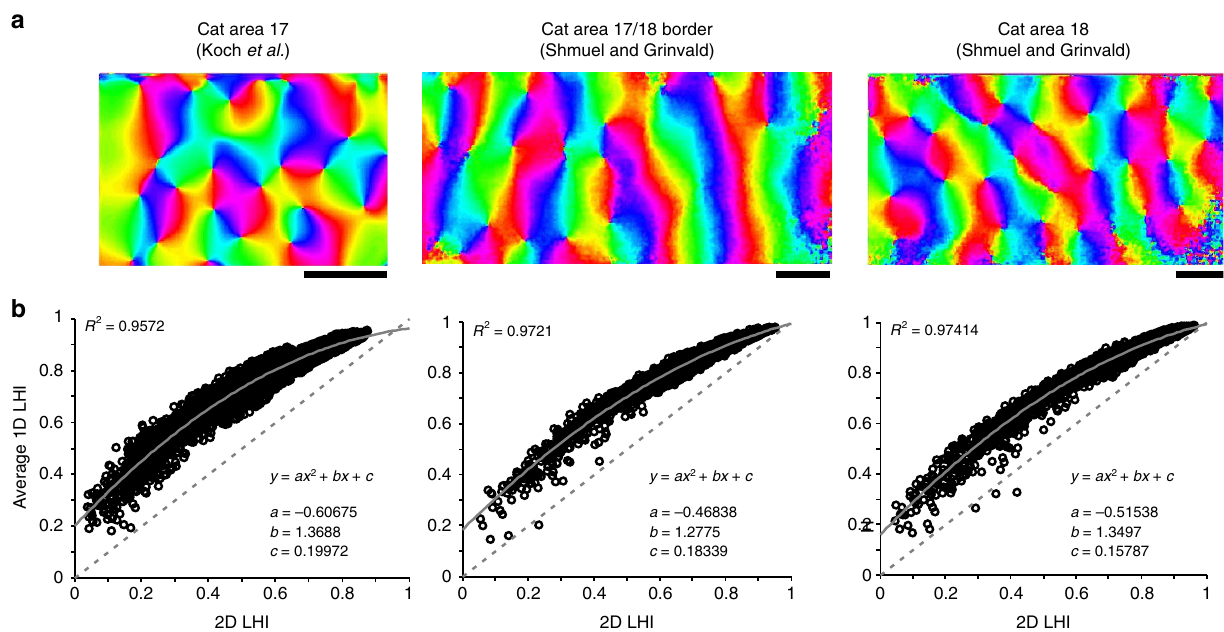
Figure 8 | LHI computation simulations. ( a ) Three different orientation maps generated from optical imaging data from our lab (left) and data published by the Grinvald lab (middle and right). Scale bars below maps represent 1mm in length. ( b ) Plots comparing 2D LHI calculation around 5,000 randomly chosen map locations with the average 1D LHI calculation of 8 radial angles of penetration. Solid grey lines depict the quadratic best fit polynomial. R 2 values are given for this curve and the best-fit coefficients. Dashed grey lines depict the line of